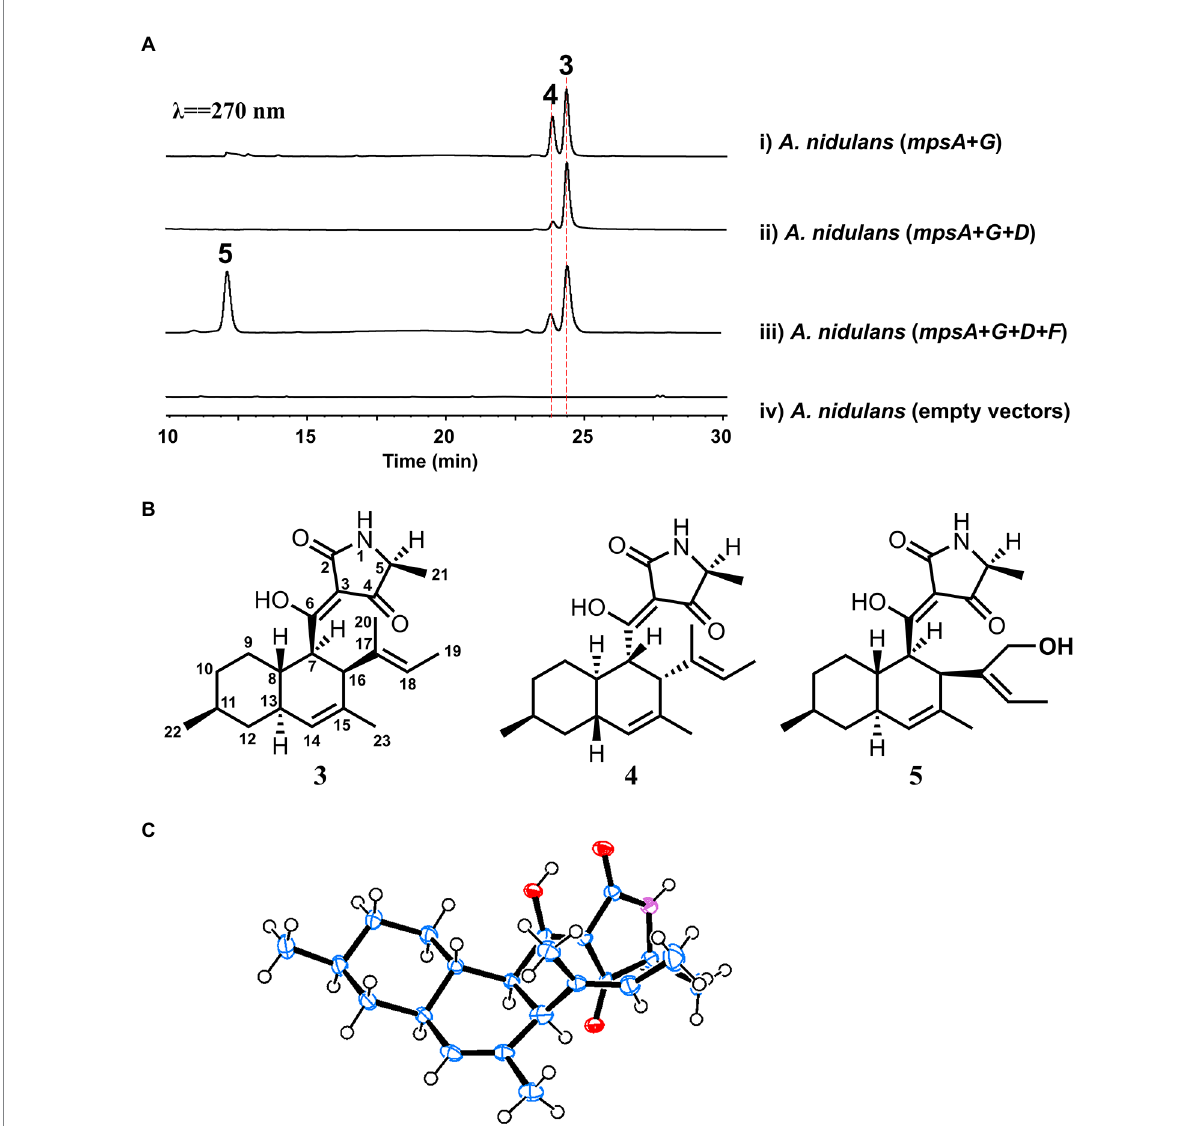
FIGURE 3 Biosynthesis of macrophasetins. (A) Metabolites analysis of heterologous reconstitution of the mps cluster in A. nidulans . The traces are HPLC with λ = 270 nm. (B) The structures of the characterized compounds. (C) Crystal structure of 3